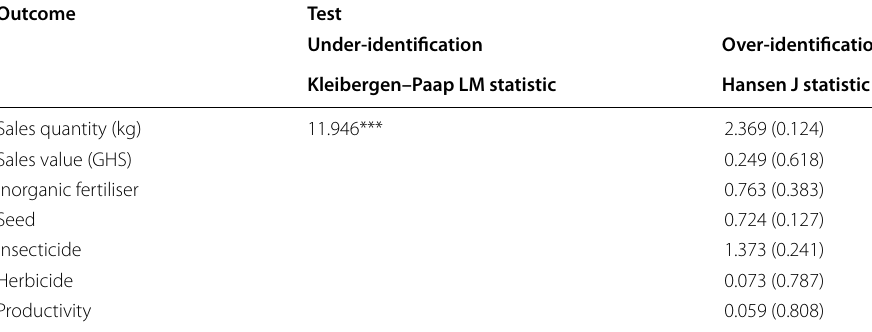
p values in parenthesis; *** p <